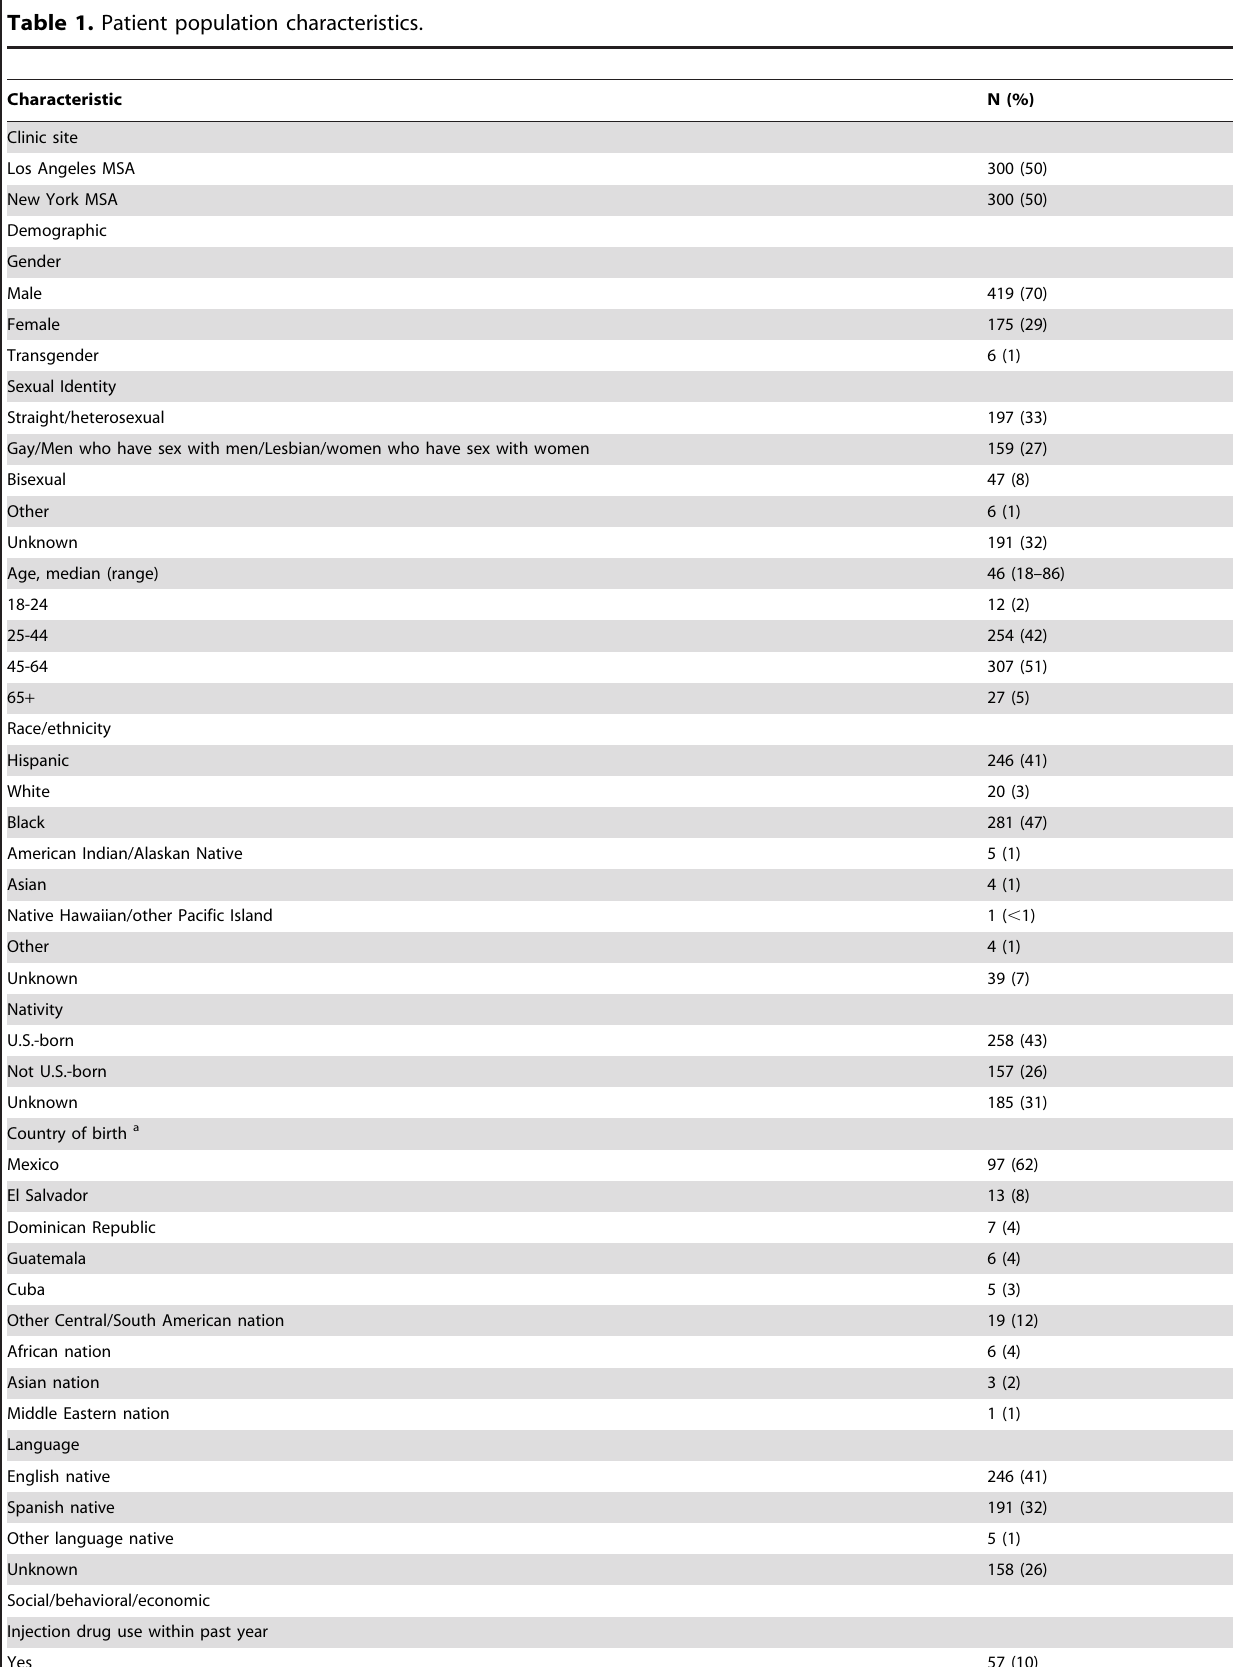
Table 1. Patient population